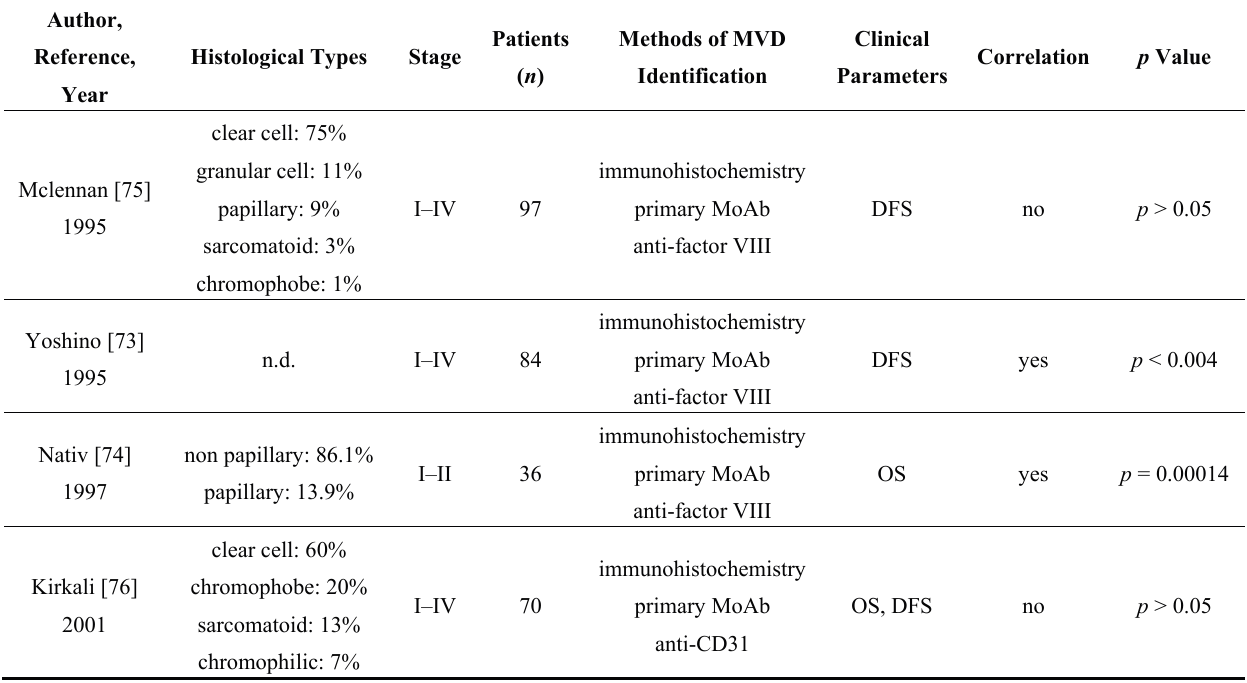
Table 3. Studies correlating microvascular density (MVD) with prognosis in renal cancer